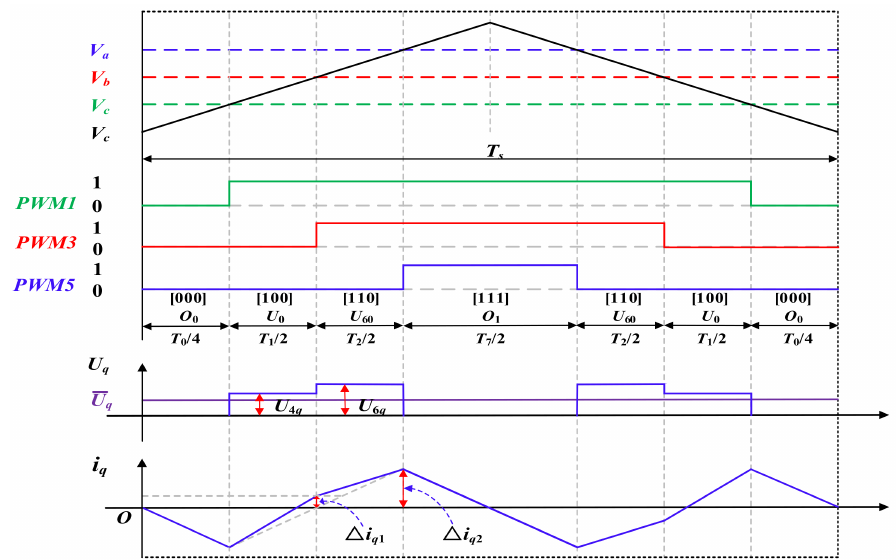
Figure 3. The pattern of the SVPWM in Sector I and q-axis current ripple.